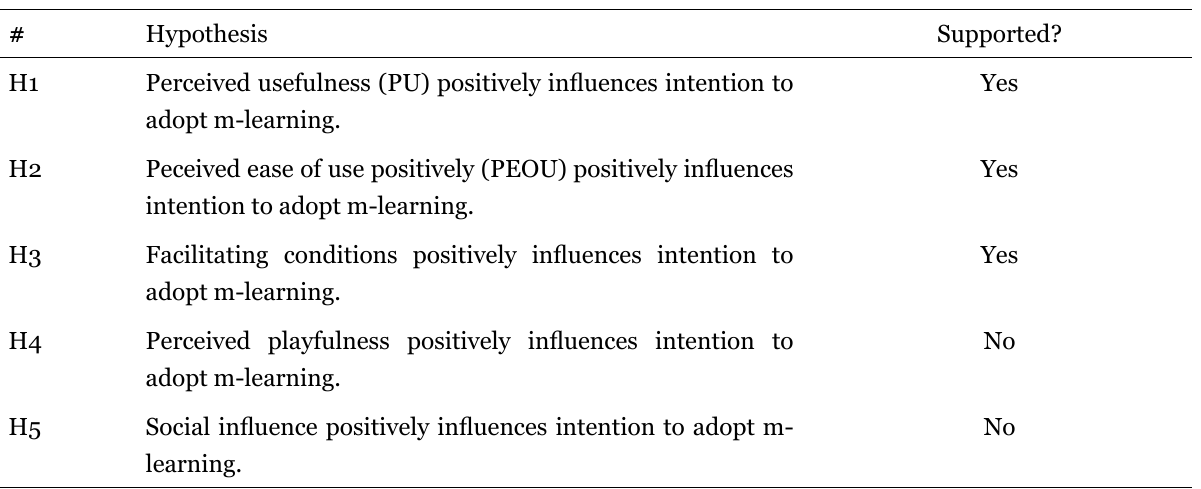
Overall Results of Hypotheses